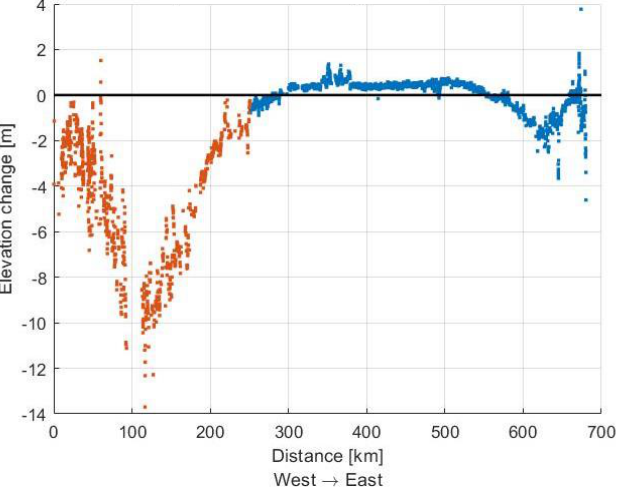
Figure 12. Comparison of crossing points along the expedition route with modified elevation change at the west coast. Blue color = 2020; orange color = 2021.